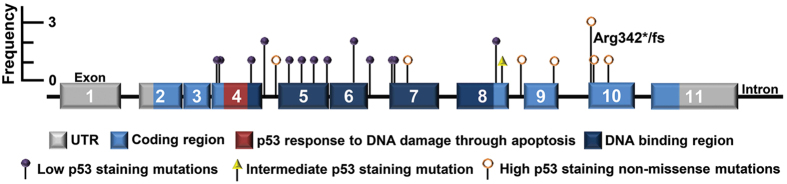
Distribution of non-missense low and high expression TP53 mutations.Grey exons mark the un-translated regions (UTR), light blue exons denote the coding regions, while dark blue exons within the coding region correlate with the DNA binding domain. The dark red region marks the p53 response to DNA damage through apoptosis area. Intronic areas are shown by the black line joining exons. All 26 non-missense mutations identified in our cohort are displayed along TP53. Mutations that resulted in accumulated p53 are identified with open orange circles. The mutation that resulted in ‘Intermediate’ p53 staining is identified as a yellow triangle. Mutations that resulted in loss of p53 expression are identified as closed purple circles. Mutations occurring more than once are indicated.